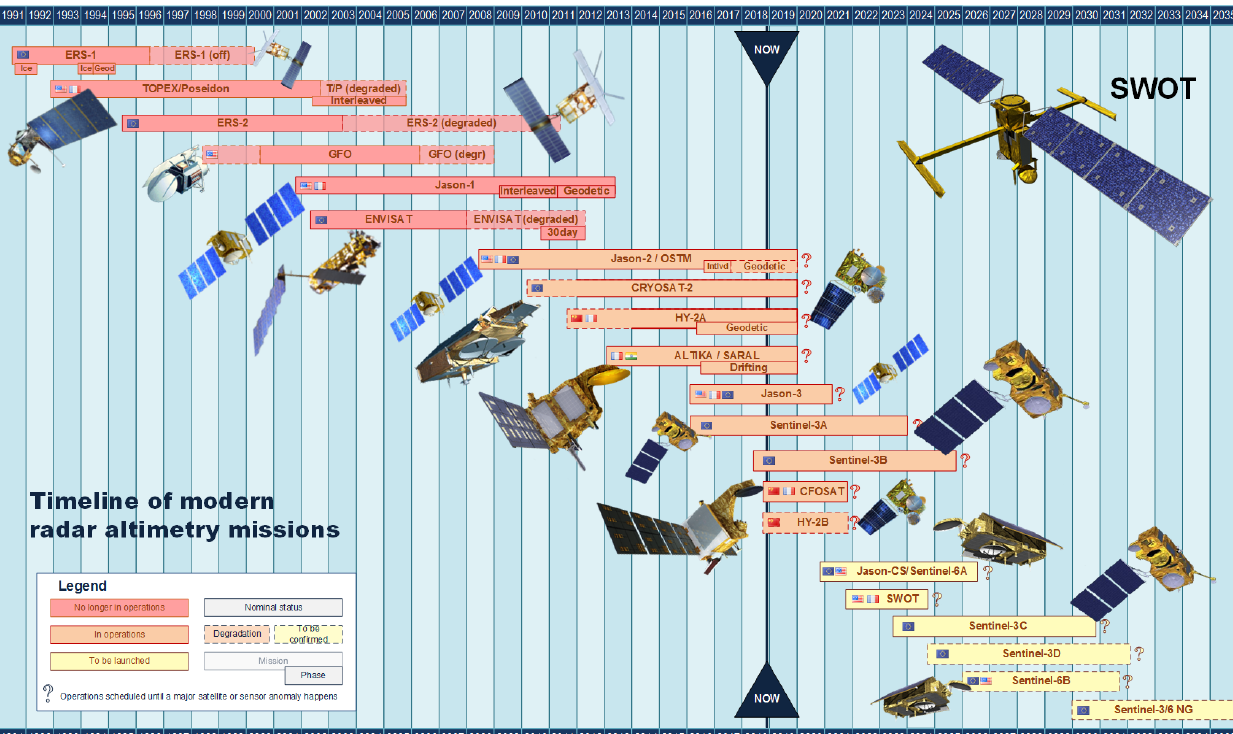
Figure 1. Timeline of the altimeter missions used in the multi-mission DUACS DT2018 system.